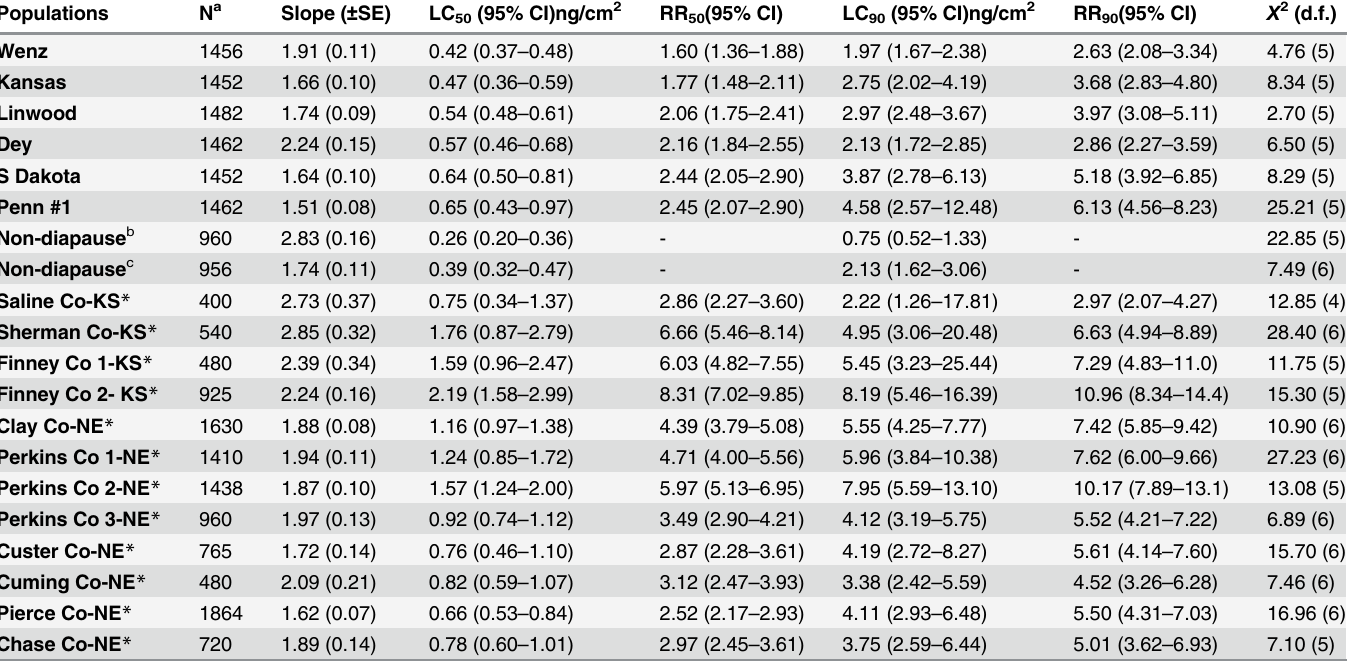
Table 3. Susceptibility ( ± 95% Confidence Interval) of western corn rootworm neonates by contact to bifenthrin of laboratory colonies from Brook- ings, SD, including one from a commercial vendor, and from field populations. Resistance ratios compared with lowest non-diapause LC 50 ; bioassays conducted in 2014, except Kansas populations were conducted in